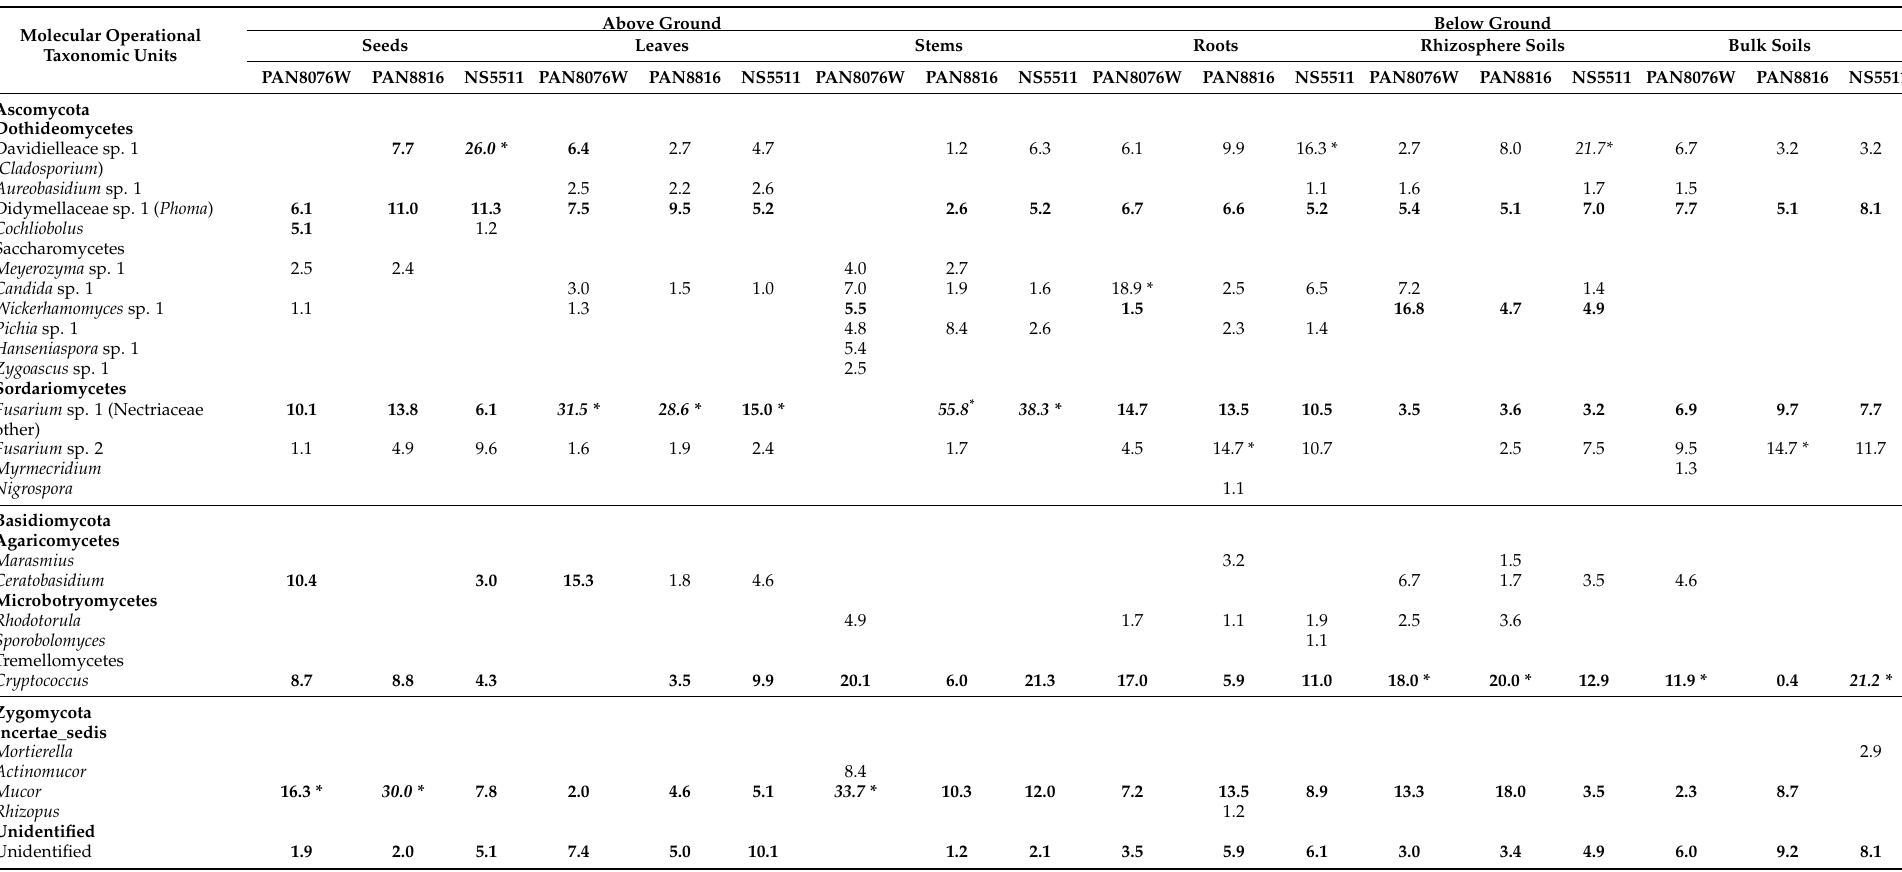
Table 3. Summary of the relative abundance (%) of Molecular Operational Taxonomic Units (MOTUs) taxa that were assigned at genus level with abundances ≥ 1% for the different sorghum cultivars and above- and below-ground